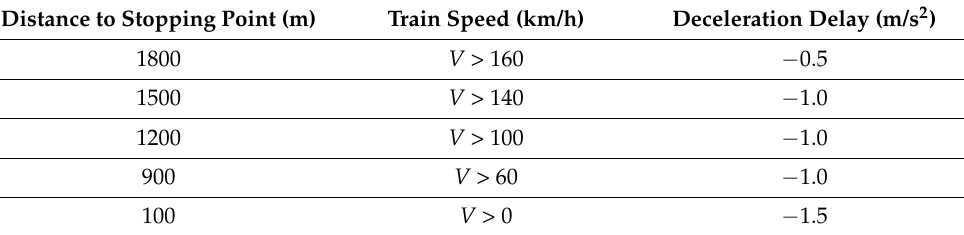
Table 1. Graduation of braking